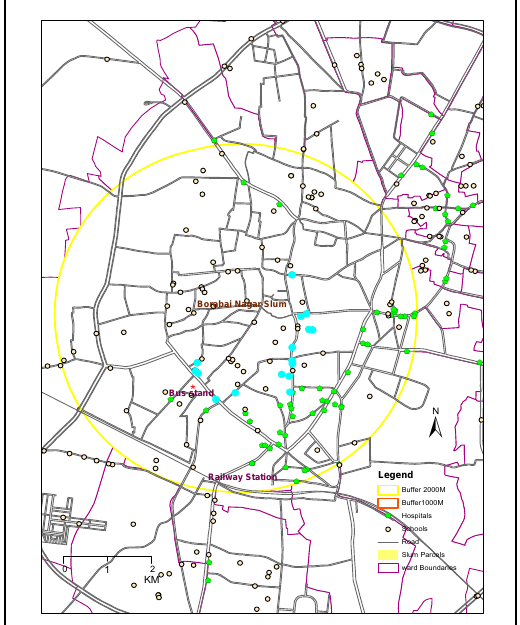
Figure6 Checking the accessibility of school and health